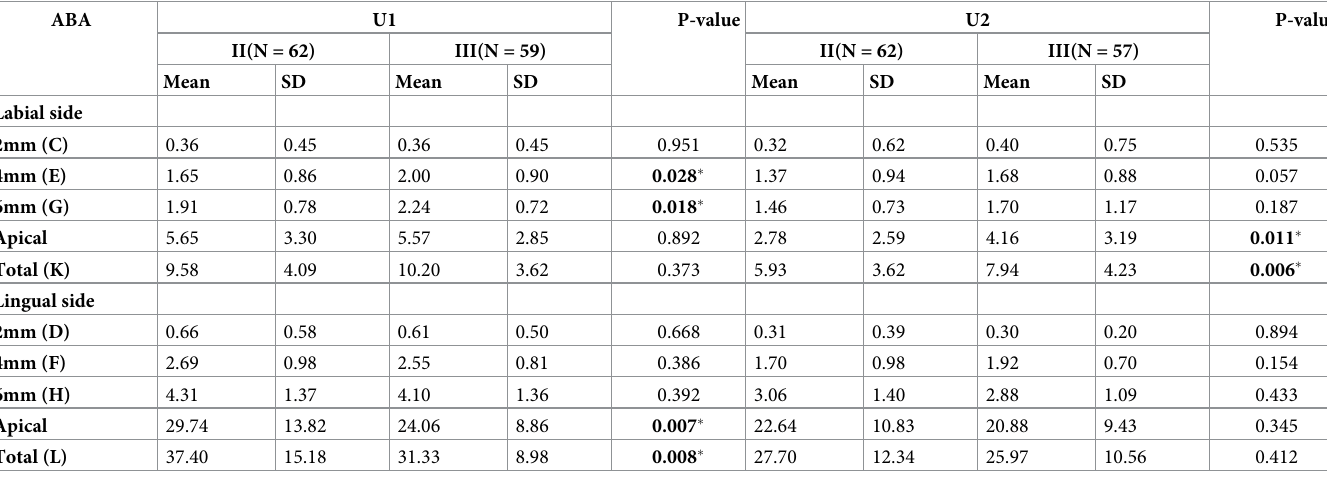
C and D, alveolar bone area (ABA) at 2 mm above the CEJ line; E and F, ABA at 4 mm above the CEJ line; G and H, ABA at 6 mm above the CEJ line; I and J, apical